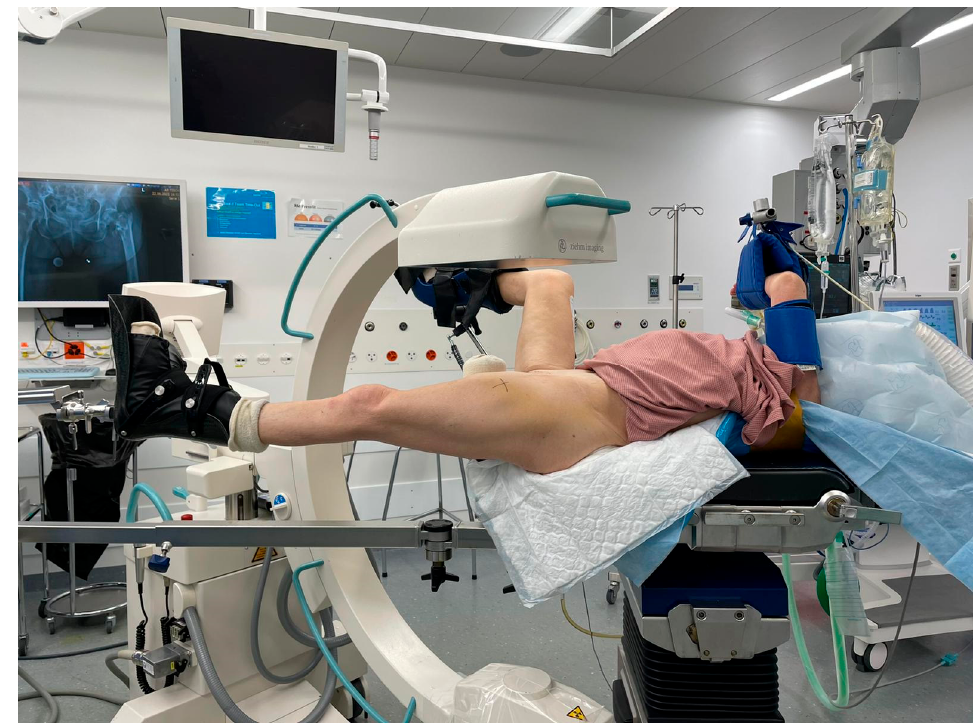
Figure 1. Setup in the operating theatre with skeletal traction applied to position the patient and reduce the fracture under fluoroscopic guidance.